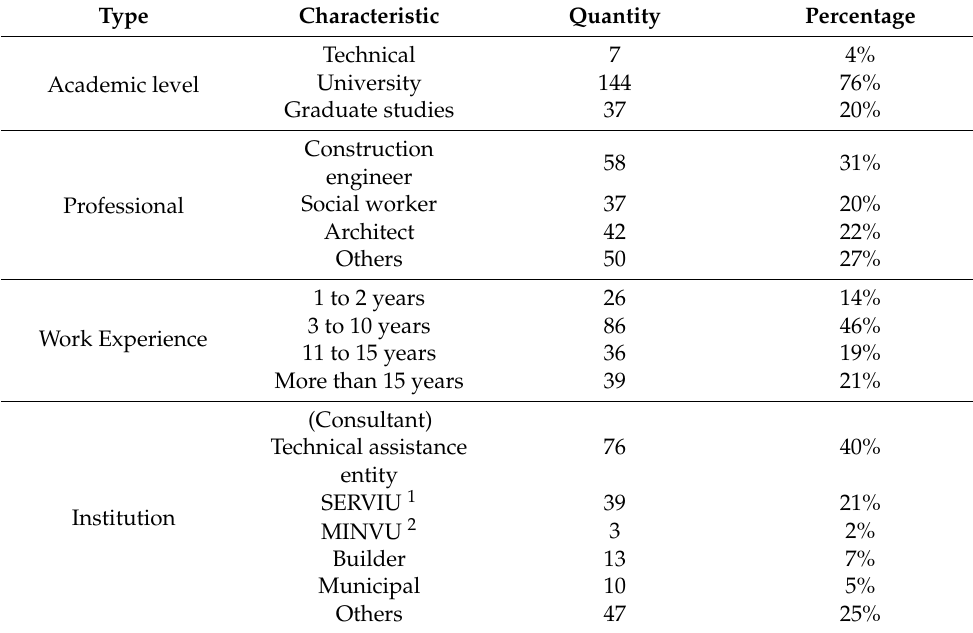
Table 2. Characterization of the